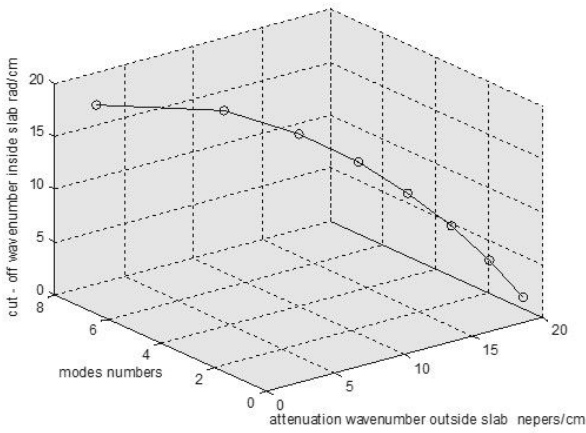
Figure 3: Quantity of attenuation with a higher mode in the graphene material